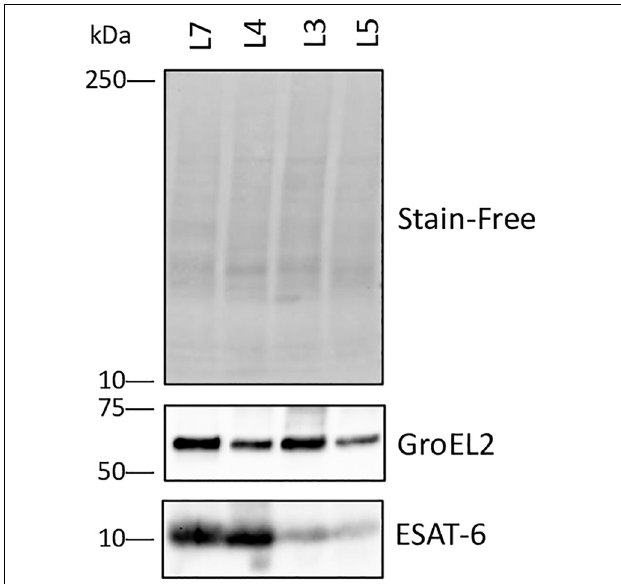
FIGURE 6 | High expression of ESAT-6 in M. tuberculosis complex (MTBC) lineage 4. Immunoblotting demonstrated a very high abundance of ESAT-6 in lineage 4 strain H37Rv. Immunoblotting of 15 µ g of total lysate from each strain using monoclonal antibody against ESAT-6 and GroEL2 confirmed the different amounts of ESAT-6 in protein samples from MTBC strains lineage 7 (L7), lineage 4 (L4), lineage 3 (L3) and lineage 5 (L5) detected by: Normalization control 1: The gel included a stain that stains tryptophan. When activated, the stain follows the protein over to the blot and can be used to detect the uniformity of transfer and that the amount of each sample loaded is similar (http://www.bio-rad.com/en-no/applications-technologies/stain-free- imaging-technology). This form of normalization control usually performs better than antibodies against housekeeping proteins for detection abnormalities. Normalization control 2: Immunoblotting with a monoclonal antibody against GroEl2. These data and the proteomics data (Supplementary file S13) indicated that the expression of GroEL2 was fairly even between the protein samples from strains of MTBC lineages 3, 4, 5, and